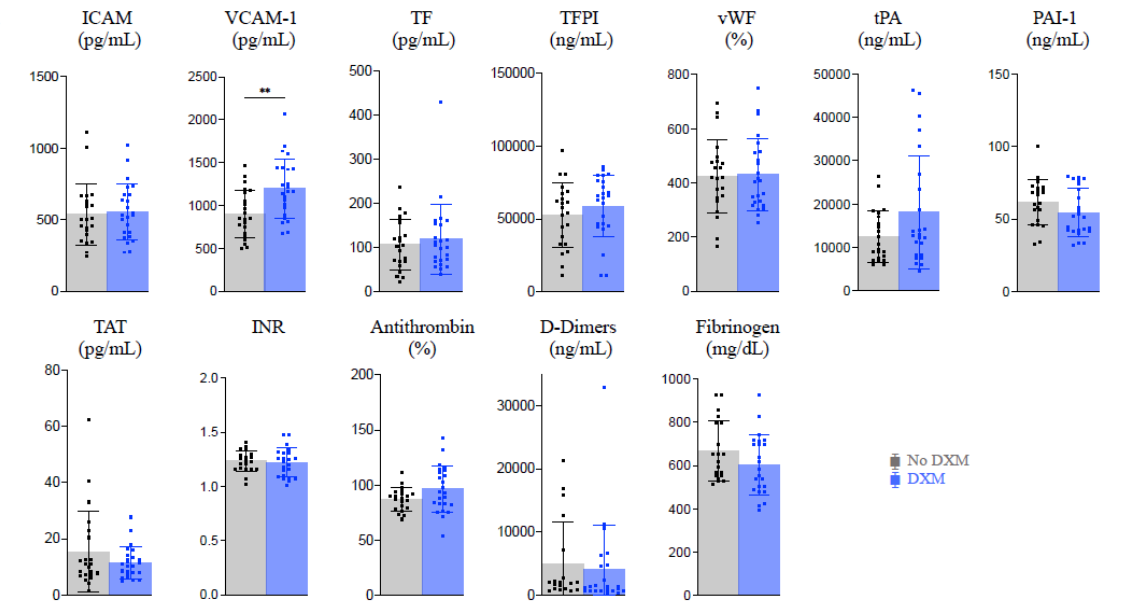
Figure 1. Corticosteroid effects on endothelial activation ( A ) and coagulation ( B ) in critical COVID-19 patients. Scatter graphs of soluble biomarkers of endothelial activation and coagulation. Individual values (dots), mean (colored rectangle), and standard deviation are presented on the graphs. ICAM, intercellular adhesion molecule; INR, international normalized ratio; PAI-1, plasminogen activator inhibitor-1; TAT, thrombin–antithrombin complex; TF, tissue factor; TFPI, tissue factor pathway inhibitor; tPA, tissue plasminogen activator; VCAM, vascular cell adhesion molecule; vWF, von Willebrand factor. ** p < 0.01.